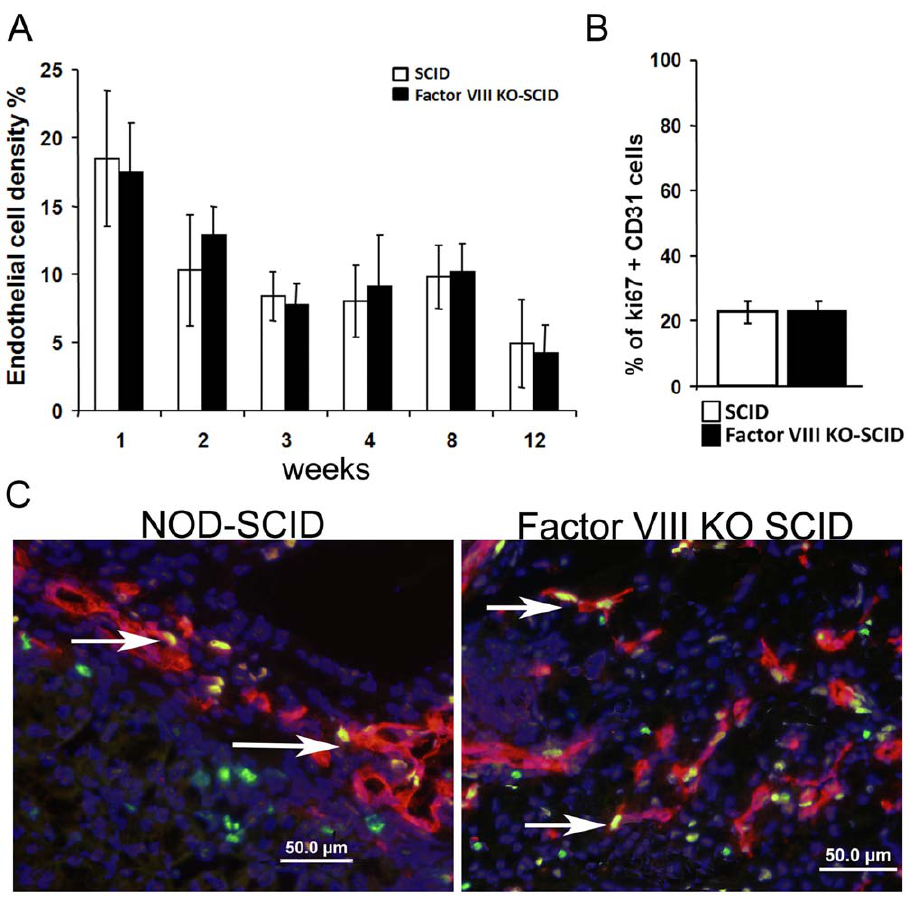
Figure 2. Angiogenesis pattern for the E42 spleen implants growth. (A). Morphometric analysis of endothelial density based on CD31 positive cells following implantation of E-42 spleen grafts into NOD-SCID or Factor VIII KO SCID recipients. (B) Quantitative evaluation of the numbers of proliferating endothelial cells per total number of nucleated proliferating cells in a square mm of the growing tissues. Analysis was performed at 2 weeks post transplantation. (C) Representative double staining of CD31 + endothelial cells (red) and Ki67 + proliferating cells (green). Nuclei are in stained in blue. Arrows outline proliferating endothelial cells (yellow) in the grafts.